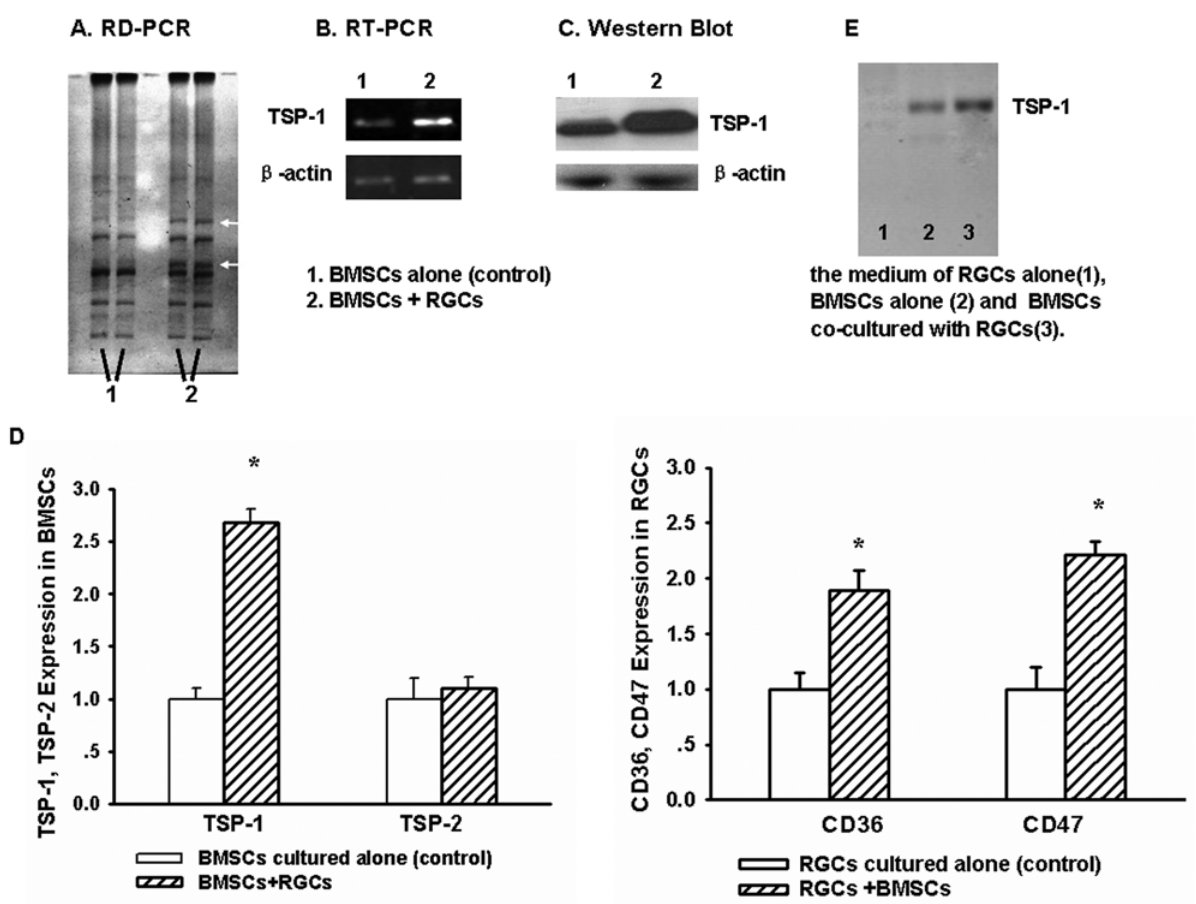
Figure 3. Patterns of differentially expressed genes in BMSCs. A , 5% polyacrylamide gel eletrophoresis demonstrates two dense bands representing upregulated genes in BMSCs co-cultured with RGC (white arrowheads). B , RT-PCR using total RNA isolated from BMSCs on day three demonstrated increased TSP-1 mRNA expression compared to controls. C , BMSC TSP-1 protein expression was increased as compared to the controls as demonstrated by Western blot. b -actin was used as a loading control in B and C. D , TSP-1, TSP-2 and TSP-1 receptors (CD36, CD47) expression were determined by real-time RT-PCR. E , Western analysis for TSP-1 in co-culture medium. *p-values # 0.05. (All data come from at least three separate